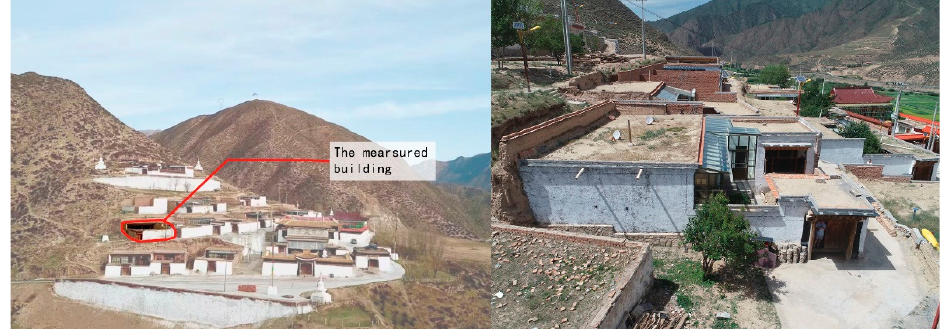
Figure 3. Current status of the Zhaxi Temple site (source: self-taken).